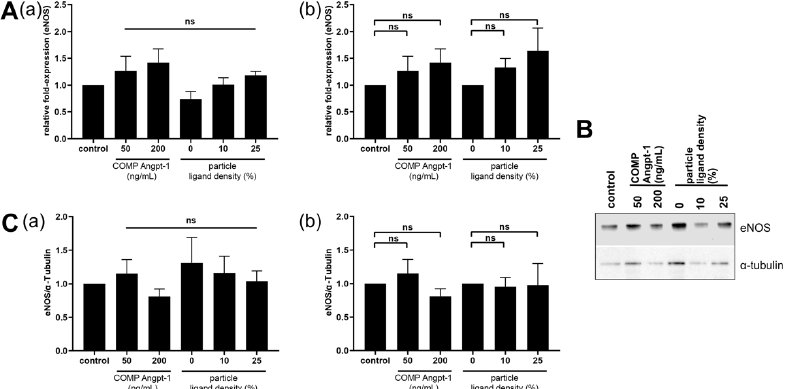
Figure 6. Impact of Angpt-1 mimetic NPs as well as COMP Angpt-1 on eNOS expression. HUVECs were incubated with Angpt-1 mimetic NPs (150 pM) of varying ligand density (0%, 10% and 25%) or COMP Angpt-1 (50 and 200 ng/mL) for 24 h. ( A ) Real time RT-PCR analysis of eNOS. Presented are the relative fold-expression levels of eNOS. (a) With increasing concentration of COMP Angpt-1, the expression of eNOS was 1.3-fold after 50ng/mL and 1.4-fold higher after 100 ng/mL relative to control. (b) Considering the Angpt-1 mimetic NP treated samples relative to particle control (NPs with 0% ligand density), the expression of eNOS was 1.3-fold and 1.6-fold higher with 10 and 25% ligand density, respectively. ( B ) Representative Western blots for eNOS. ( C ) Western blot analysis of eNOS. Presented are the relative ratios eNOS and α -tubulin expression. (a) Treatment with Angpt-1 mimetic NPs as well as COMP Angpt-1 has no impact on total eNOS expression. (b) Considering the expression ratios of Angpt-1 mimetic NP treated samples relative to 0% NP ligand density, no increase of total eNOS can be observed. Results are presented as mean ± SEM. ns: not